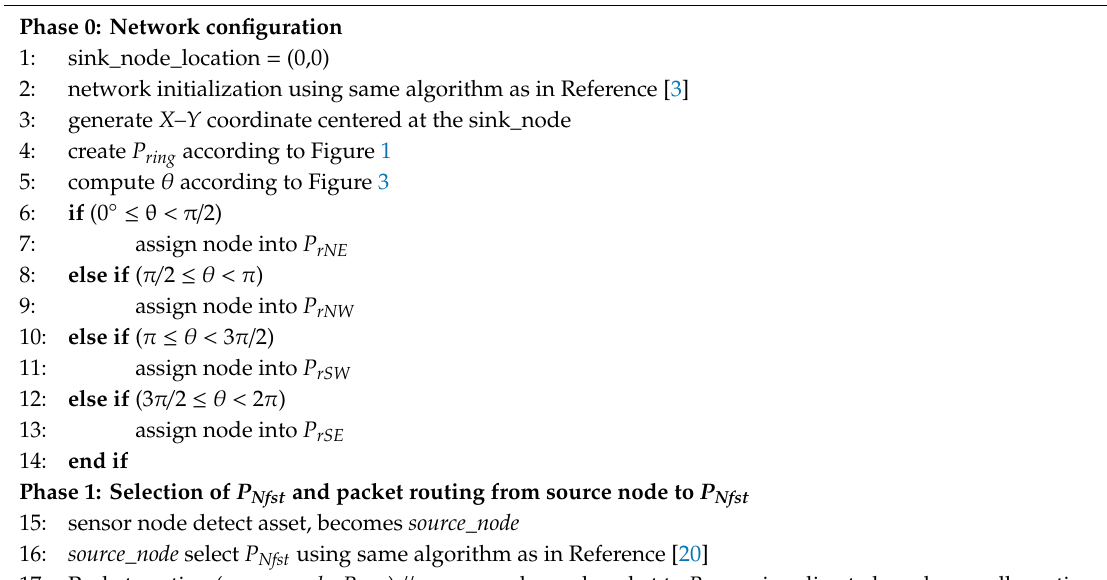
Algorithm 1. Proposed algorithm for PhaP